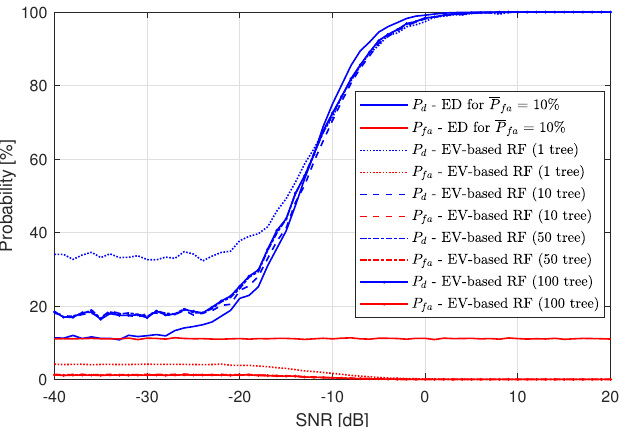
Figure 10. Resulting probability of detection P d and probability of false alarm P fa of the Energy Vector-based Random Forest method for ¯ P fa = 10%.